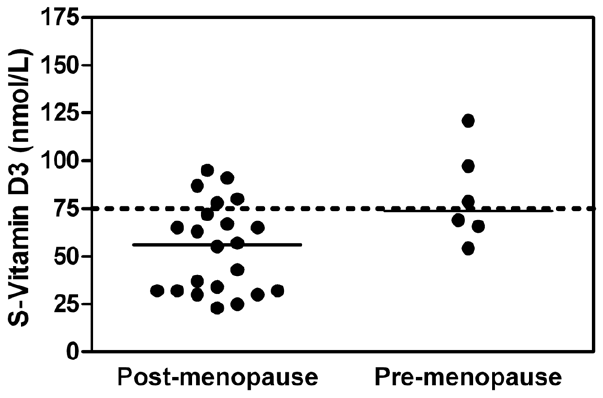
Figure 1. Low levels of vitamin D 3 in postmenopausal women. Serum vitamin D 3 levels in postmenopausal women are low compared to premenopausal women, P , 0.05 (Mann-Whitney test). Individual data are presented with median levels (56 nmol/L and 74 nmol/L). The recommended level of 75 nmol/L is marked with a dotted line.